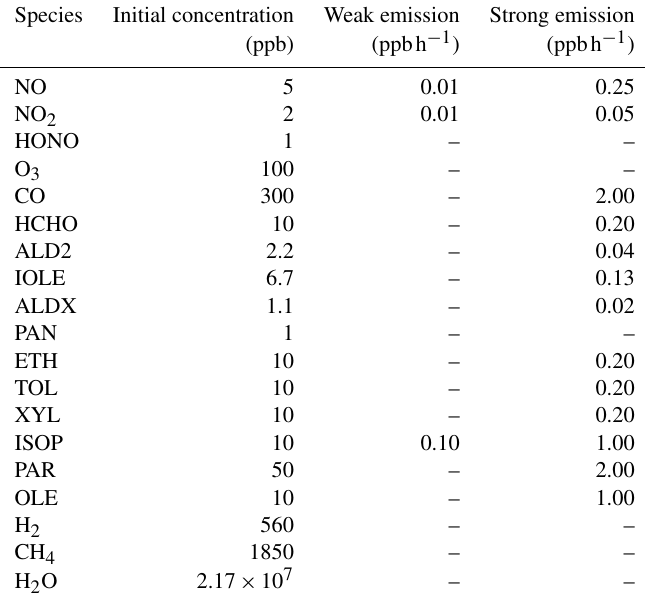
Table 1. The initial air composition and the surface emission intensities used in two different simulation scenarios. This initial condition was adapted from Saylor and Ford (1995) and Sandu et al. (1997) and represents a heavily polluted environment with 70% relative humidity.